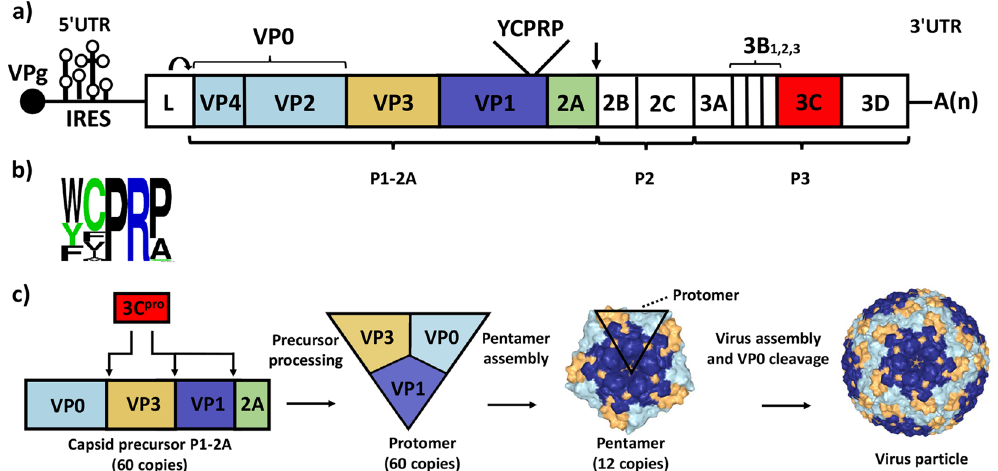
Figure 1. Picornavirus capsid assembly. ( a ) The genome organization of FMDV is shown. The viral RNA encodes a large polyprotein that is processed to yield precursors and finally mature products. The FMDV capsid protein precursor (P1-2A) includes the conserved YCPRP motif near the C-terminus of VP1. The Leader protease (L pro ) cleaves itself from the P1-2A precursor. Ribosomal skipping at the C-terminus of 2A is marked with an arrow. The 3C pro (red) is responsible for cleavage of all other junctions. ( b ) A logoplot showing variation in this conserved motif amongst a collection of picornavirus sequences (from http://www.virology. wisc.edu/acp/Aligns/aligns/picorna.p1) was generated using https://weblogo.berkeley.edu. ( c ) The pathway of capsid assembly is shown from the processing of the capsid precursor P1-2A by the 3C pro , to the formation of protomers, the assembly of pentamers and finally the generation of complete capsids. The cleavage of VP0 to VP4 and VP2 occurs during the formation of virus particles. The structures of the pentamer and virus particle are from PDB 4GH4 21